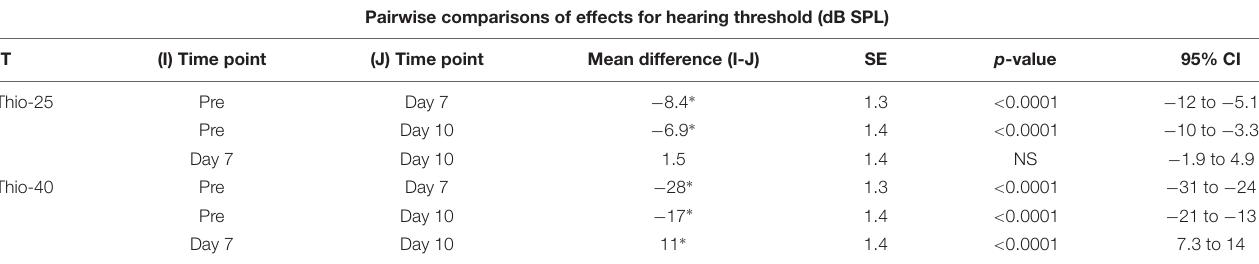
TABLE 1C | Pairwise comparisons of the analysis results presented in Table 1A . Pairwise comparisons of effects for hearing threshold (dB